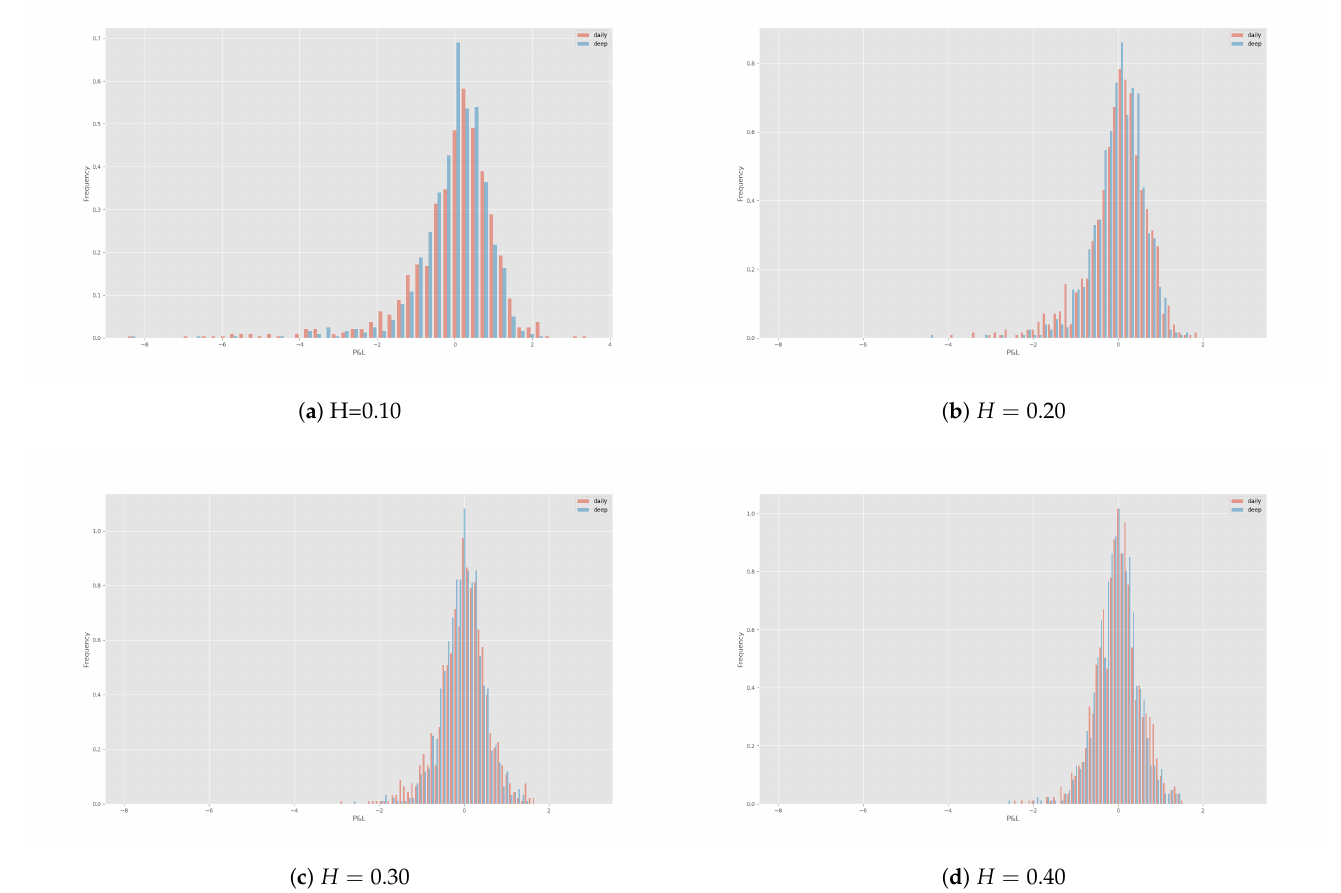
Figure 6. P&L distributions of rBergomi model hedge (red) vs. deep hedge with proposed architecture (blue) for different Hurst parameters realised on 10 3 sample